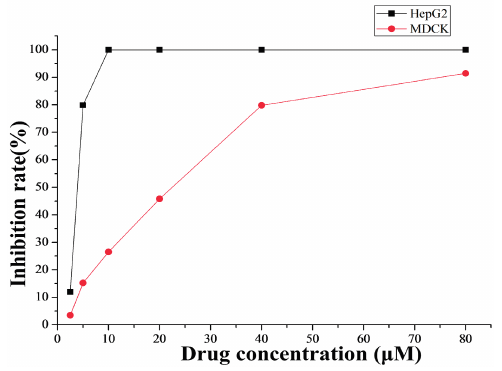
Figure 1. Cytotoxicity of 4a against HepG2 tumor cells and MDCK cells. The cytotoxicity of 4a was determined by MTT assay.